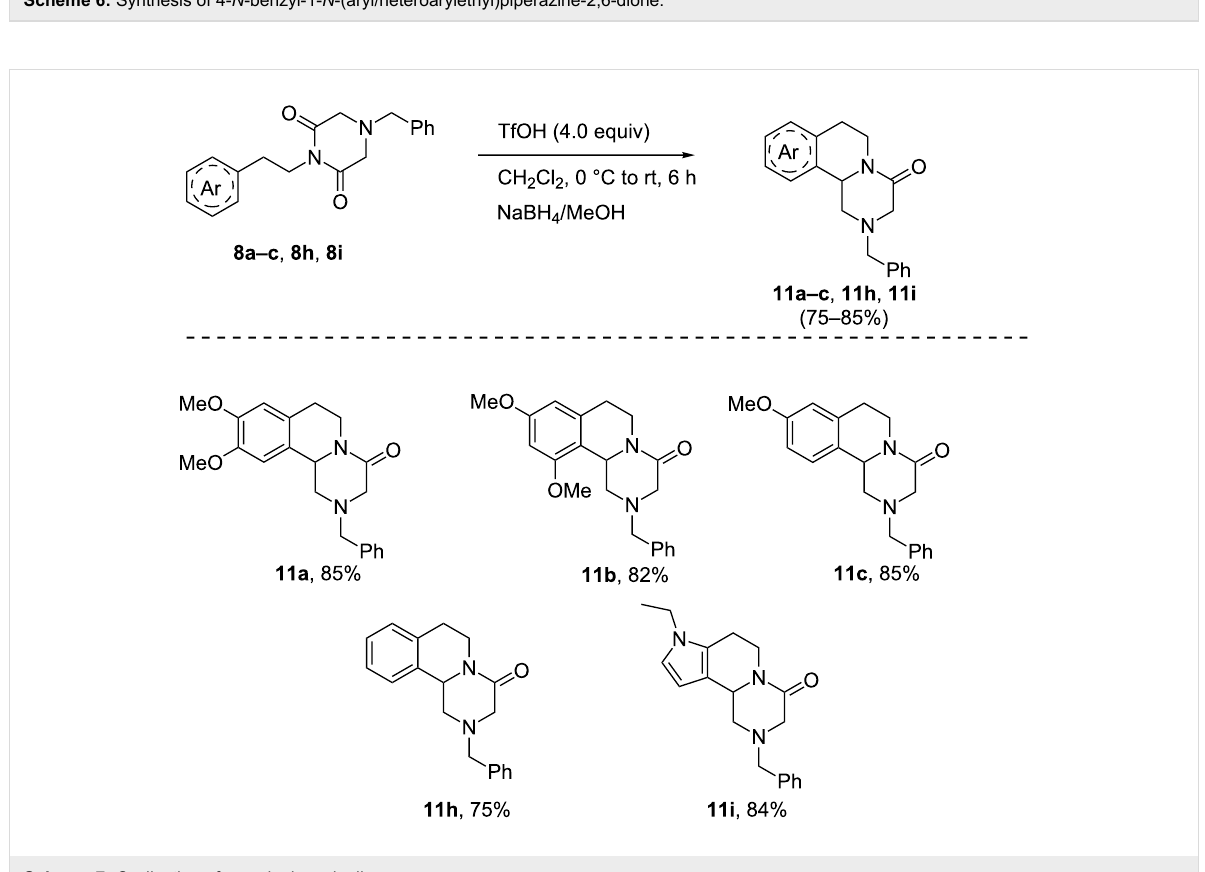
Scheme 7: Cyclization of